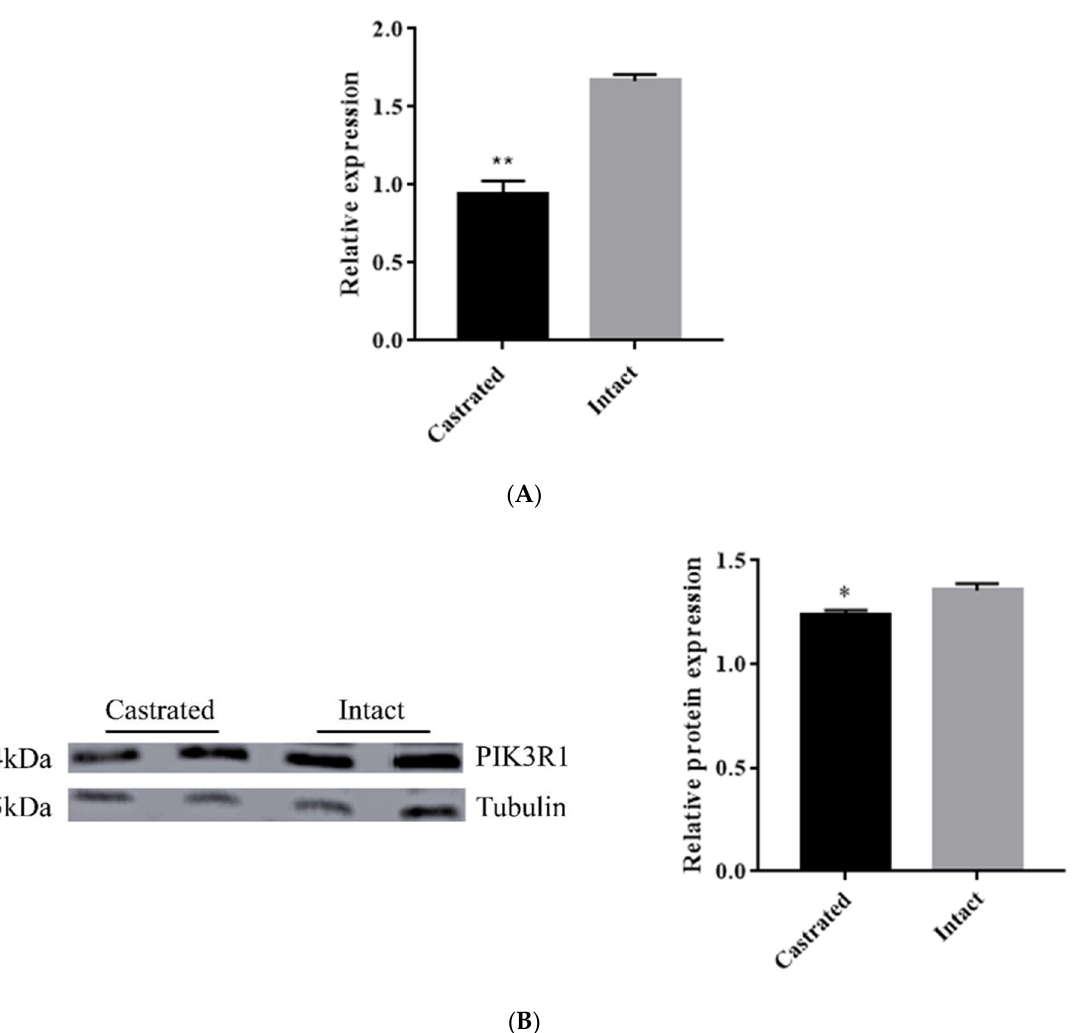
Figure 6. Expression of PIK3R1 protein and mRNA in backfat tissue. ( A ) mRNA expression of PIK3R1 showed significant difference in backfat tissues of castrated and intact pigs. ( B ) Western blotting showed decreased protein expression of PIK3R1 in castrated compared to intact pigs. The protein level of PIK3R1 was detected using Western blot in backfat tissue of castrated and intact pigs. Data are means ± SDs. * Indicates p < 0.05, ** indicates p < 0.01. Original western blot figures in Figure S4.